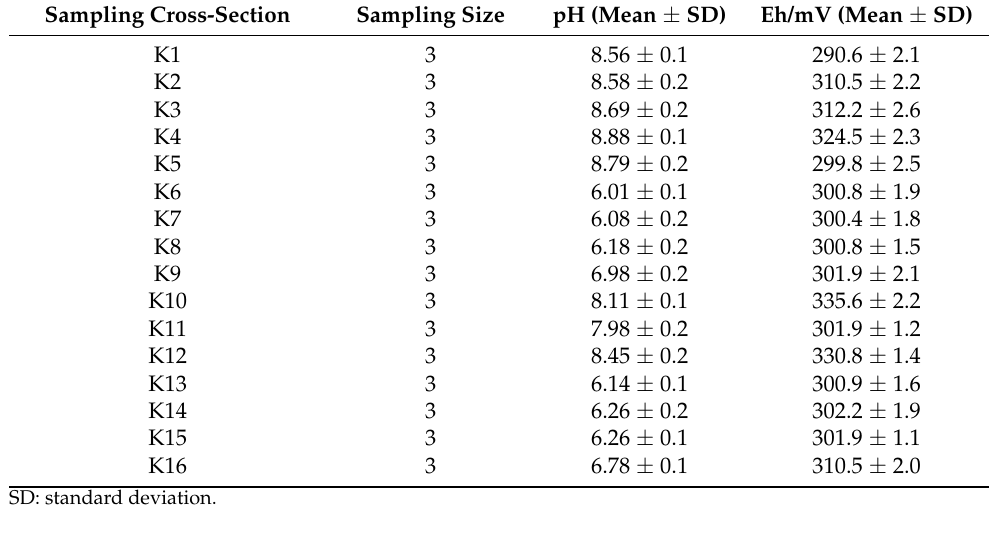
Table 3. pH and Eh of PTEs in river water.